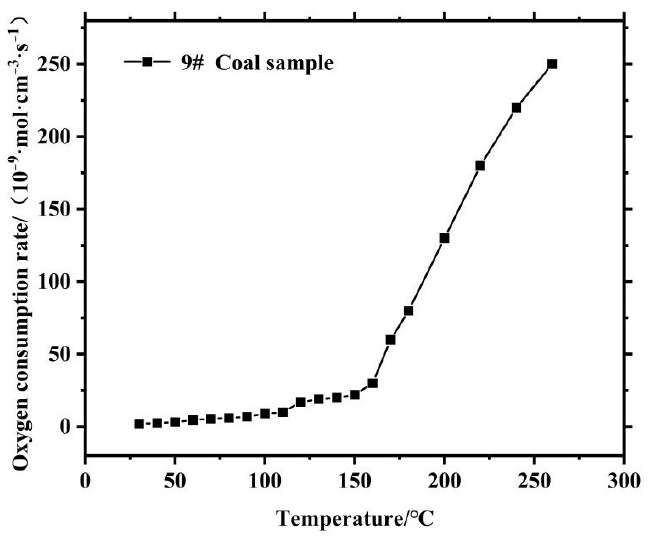
Figure 3. The trend of oxygen consumption rate with temperature during the warming process of the coal sample.